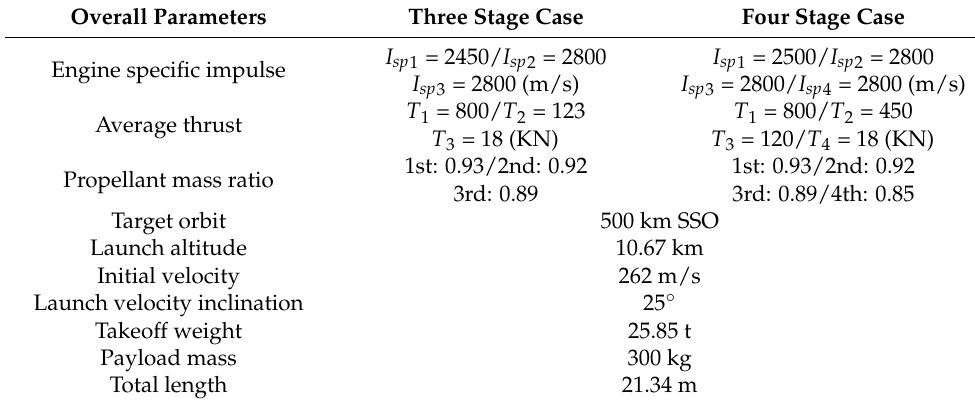
Table 1. Overall parameter design of the solid rocket. Overall Parameters Three Stage Case Four Stage Case Engine specific